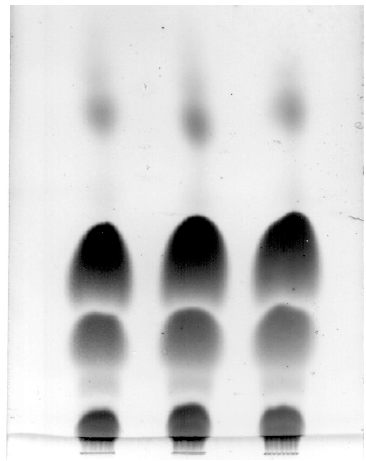
Figure 1. Lipid classes of the M. ellitica on Sorbfil thin layer chromatography (TLC).